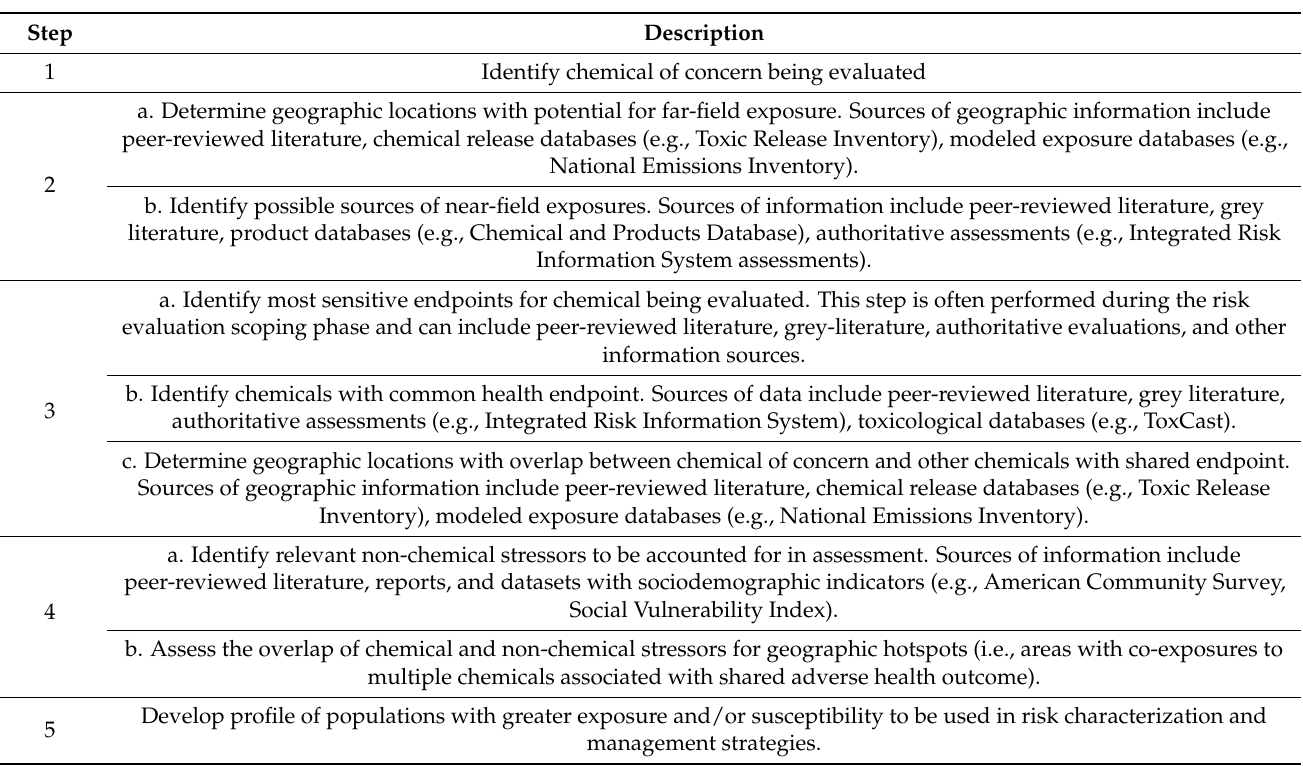
Table 1. GIS-based approach to identify and account for PESS in TSCA risk